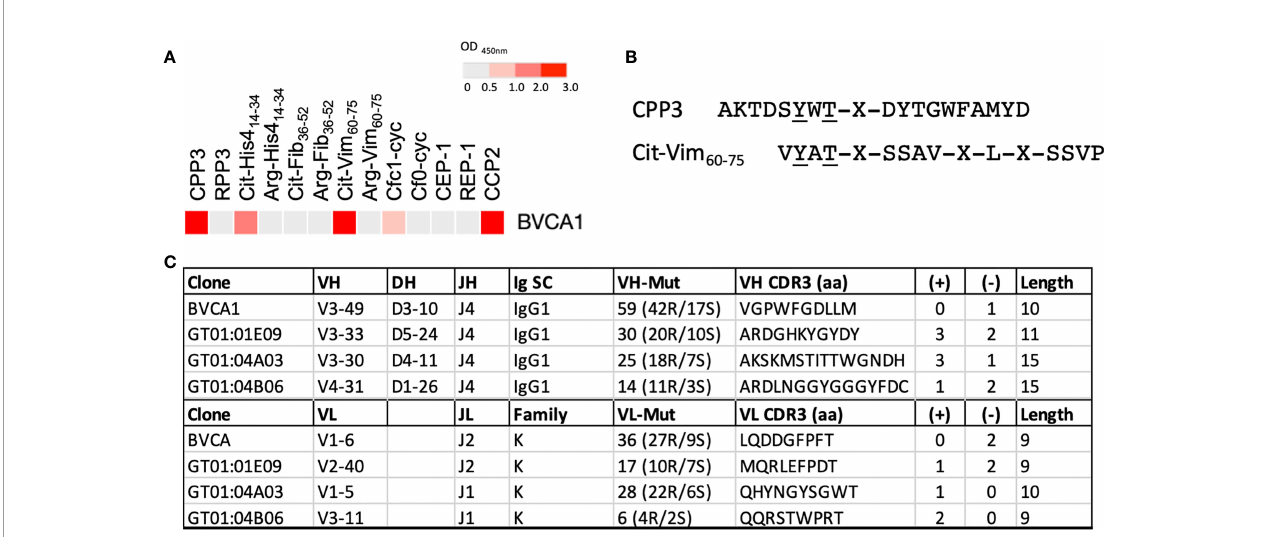
FIGURE 4 | Binding pattern for BVCA1, CPP3/Cit-Vim 60-75 peptide alignment, and Ig gene features of BVCA1 versus CPP3+ GT mAbs. (A) ELISA results for BVCA1 shown as a heat map; colors indicate binding strength (based on OD values; scale on top). (B) Peptide alignment of the citrullinated P .PAD peptide CPP3 and a citrullinated human vimentin peptide (Cit-Vim 60-75 ); identical amino acids underlined, X=citrulline. (C) Immunoglobulin (Ig) heavy (H) and light (L) chain gene features of BVCA1 and three CPP3+ GT mAbs; Ig gene variable (V), diversity (D) and joining (J) segment usage, Ig subclass (SC), L chain family, complementary determining region (CDR3) features, and number of mutations (mut) are shown. CPP3, citrullinated P .PAD peptide 3; RPP3, arginine-containing version of CPP3; Cit, citrulline; Arg, arginine; His4, Histone-4; Fib, Fibrinogen; Vim, Vimentin; Cfc1-cyc, cyclic citrullinated fi laggrin peptide 1; Cf0-cyc; arginine-containing version of Cfc1- cyc; CEP, citrullinated a -enolase peptide 1; REP, arginine-containing version of CEP-1; CCP2, cyclic citrullinated peptide(s); S, silent; R, replacement; aa, amino acids; (+)/(-), positively/negatively charged aa; Length, number of aa in the CDR3